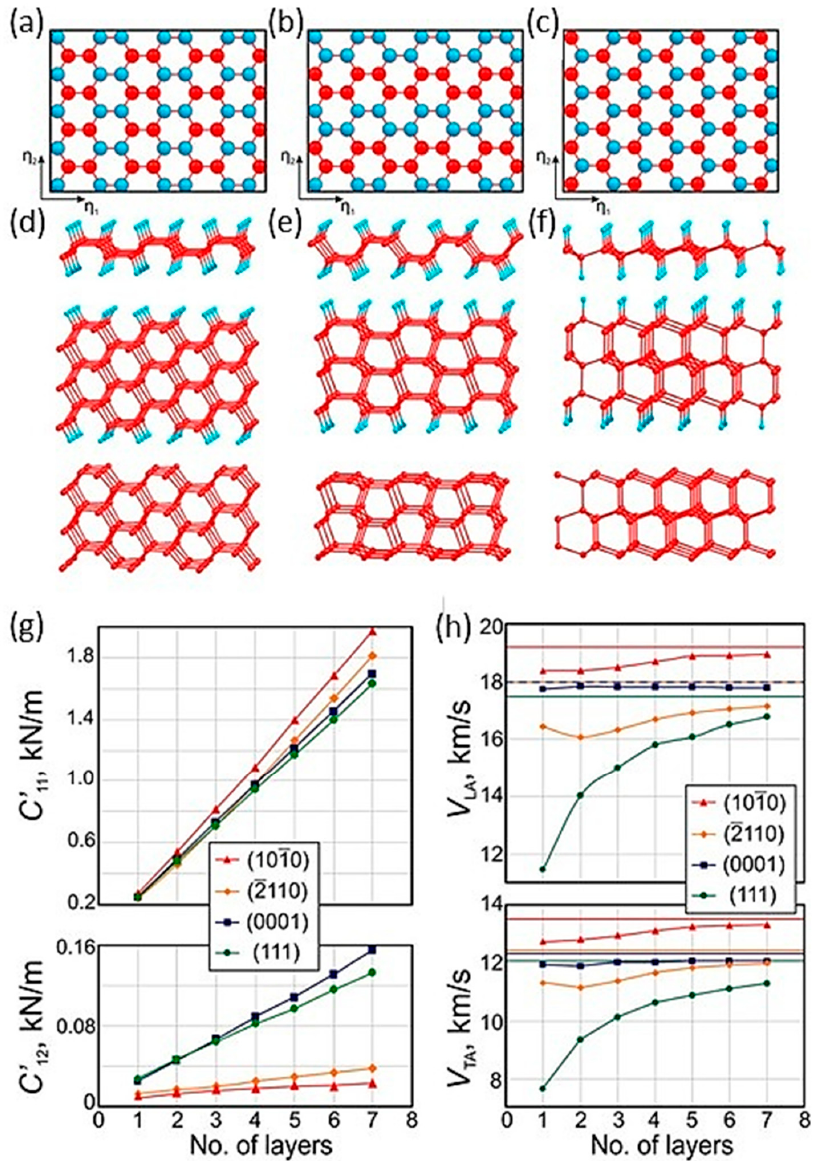
Figure 9. Schemes of the hydrogen coverage of the conformers—non-Bernal-stacked multi-graphene ( a ) “boat1”, ( b ) “boat2” and ( c ) “chair1”—showing the atomic structures of the considered graphane conformers and corresponding three-layered lonsdaleite films with hydrogenated and clean surfaces with ( d ) ( 101(cid:3364)0 ), ( e ) ( 2(cid:3364)110 ) and ( f ) (0001) crystallographic orientations. Dependence of the ( g ) elastic constants C11 ′ and C12 ′ and ( h ) velocities of the longitudinal V LA and transverse V TA acoustic waves of the lonsdaleite films with ( 101(cid:3364)0 ) ( ▲ ), ( 2(cid:3364)110 ) ( ◆ ) and (0001) ( ■ ) surfaces for different numbers of layers in comparison with diamond films with (111) surfaces ( ● ) [36].